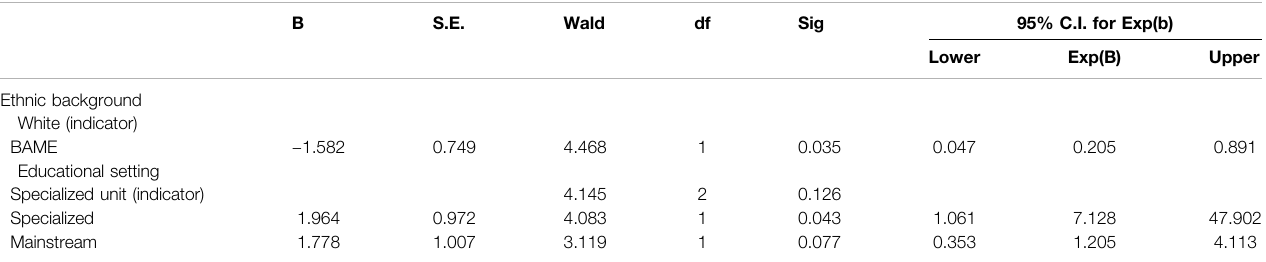
TABLE 5 | Parameter estimates for the effect of ethnic background on detrimental effect of school closures on parental mental health.